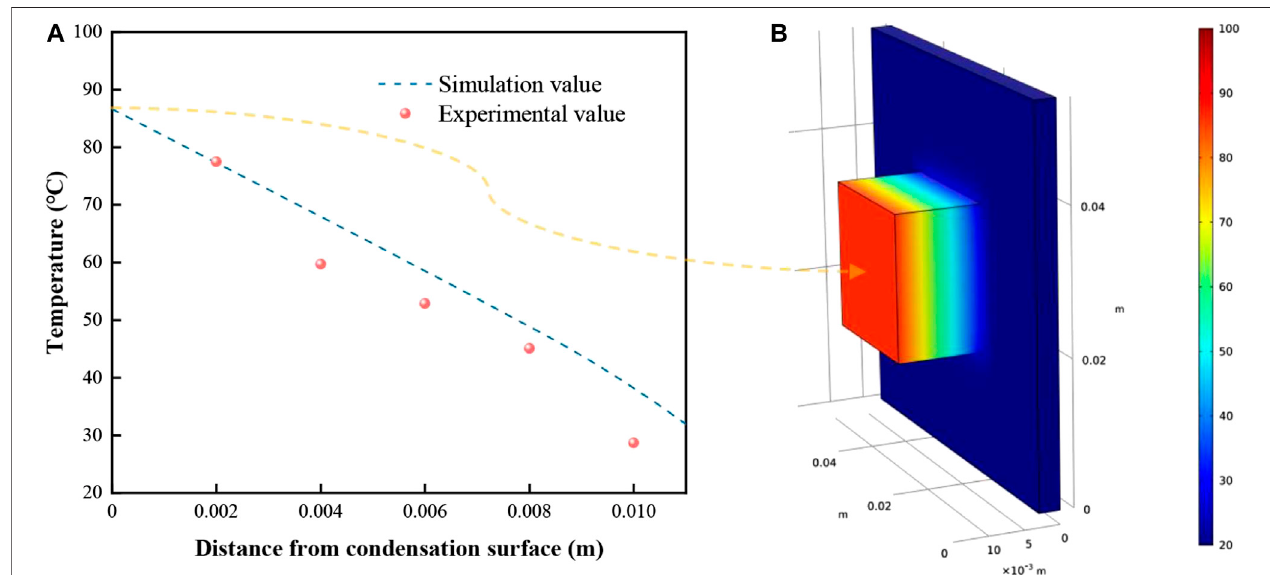
FIGURE8| Comparisonofsimulationandexperimentalresultsofheattransferinthecondensateblock. (A) isthechangeoftemperatureatdifferentpositionsfrom the condensation surface, (B) is the three-dimensional distribution of the temperature fi eld of the condensation block.